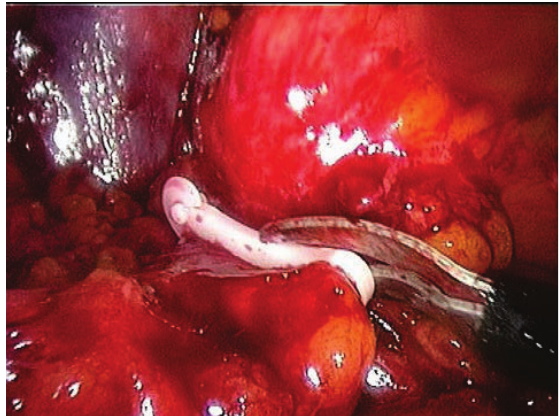
Figure 3. Clipped fistulous loop was